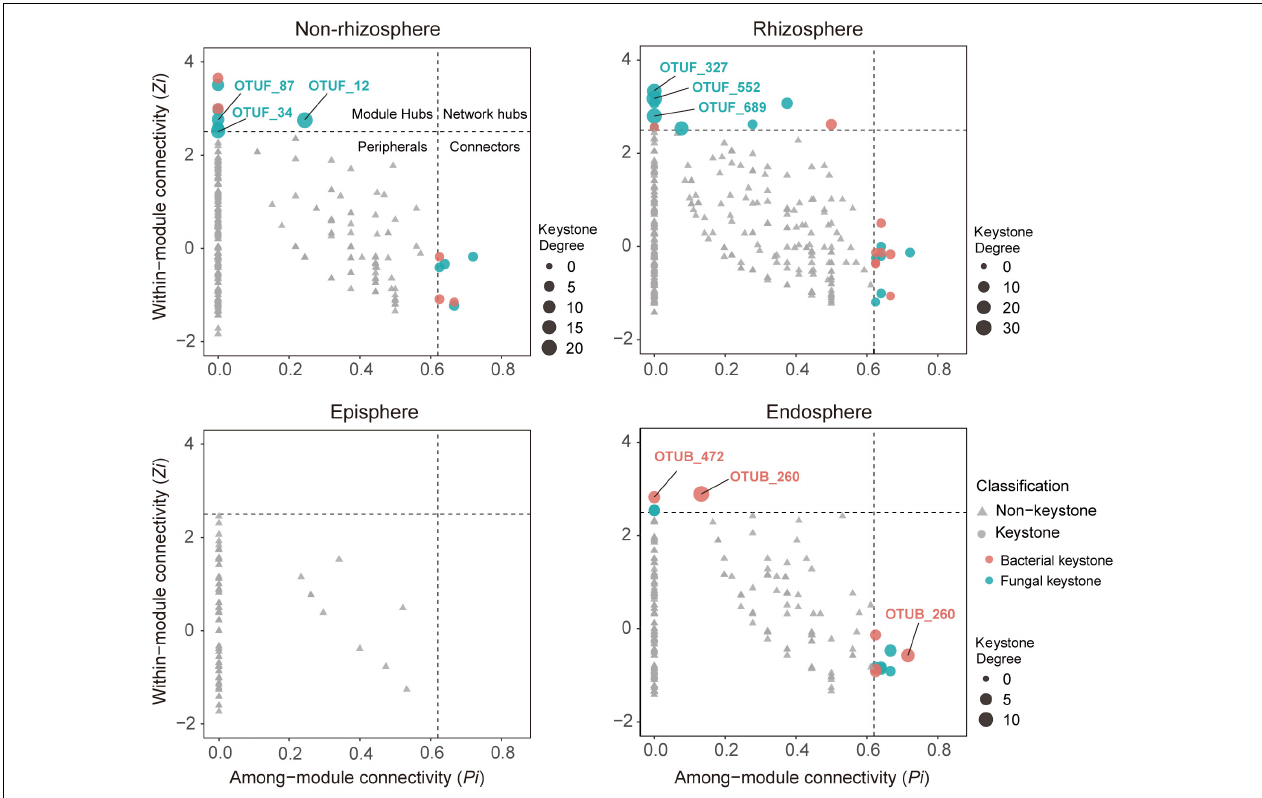
FIGURE 2 | Topological features of keystone taxa in bacterial-fungal association (BFA) networks across four compartments in the soil-mangrove root system. Each bacterial operational taxonomic unit (OTU) is represented as OTUB, and each fungal OTU is represented as OTUF. Module hubs have within-module connectivity ( Zi ) > 2.5, whereas connectors have among-module connectivity ( Pi ) > 0.62. Keystone taxa and their domains are classified by shape and color, respectively. The size of each node indicates its degrees; keystone taxa with top three highest degrees in each compartment are